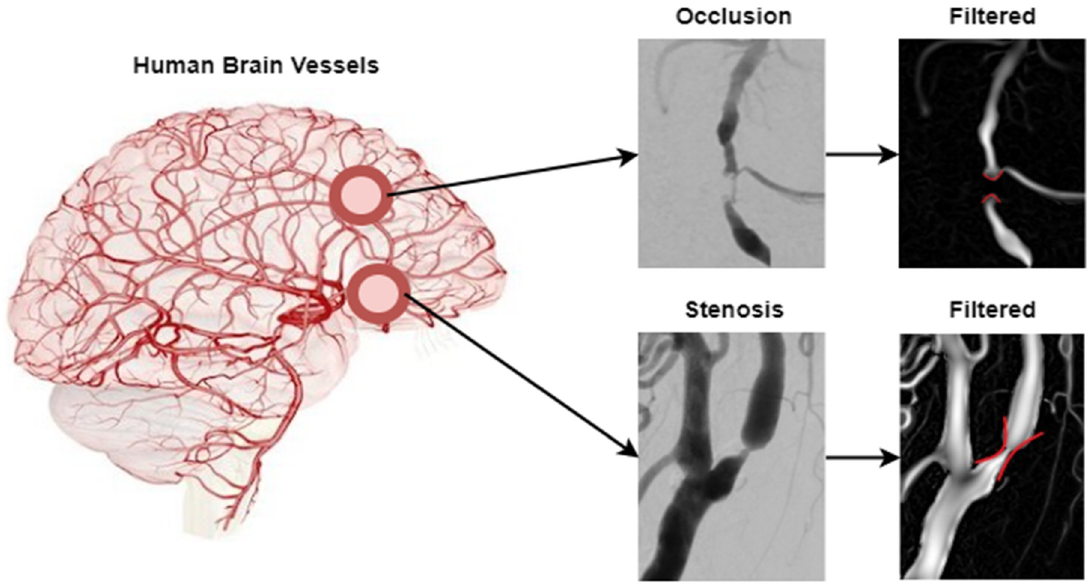
Figure 3. Example of how Meijering filter shows a clear DSA image of occlusion and stenosis in internal carotid arteries.